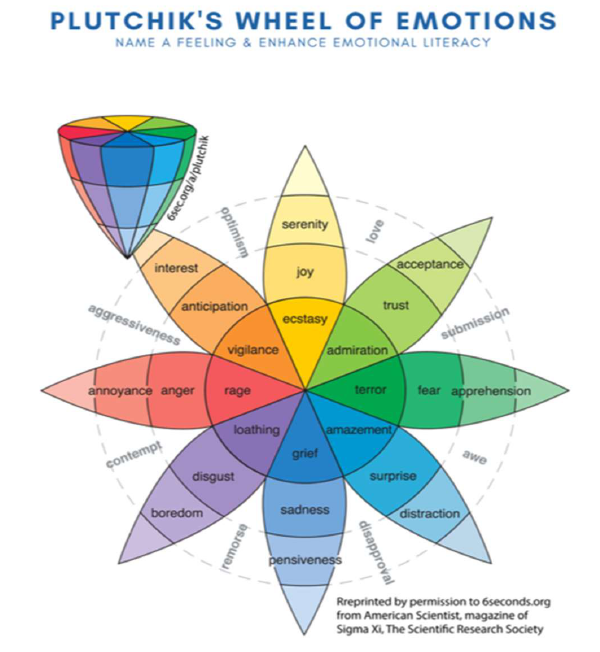
Figure 2 . Sample of dataset for seven types of emotion